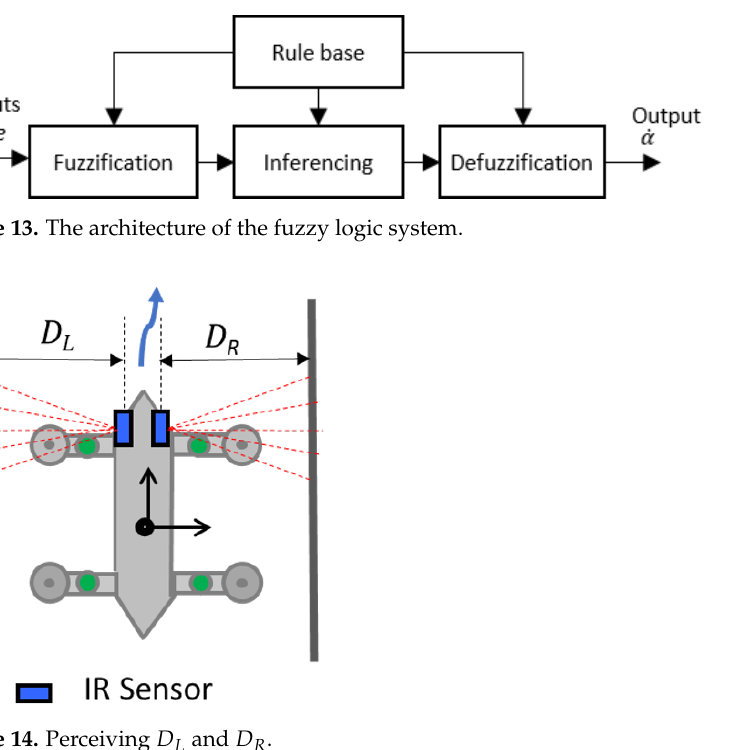
Figure 14. Perceiving D L and D R